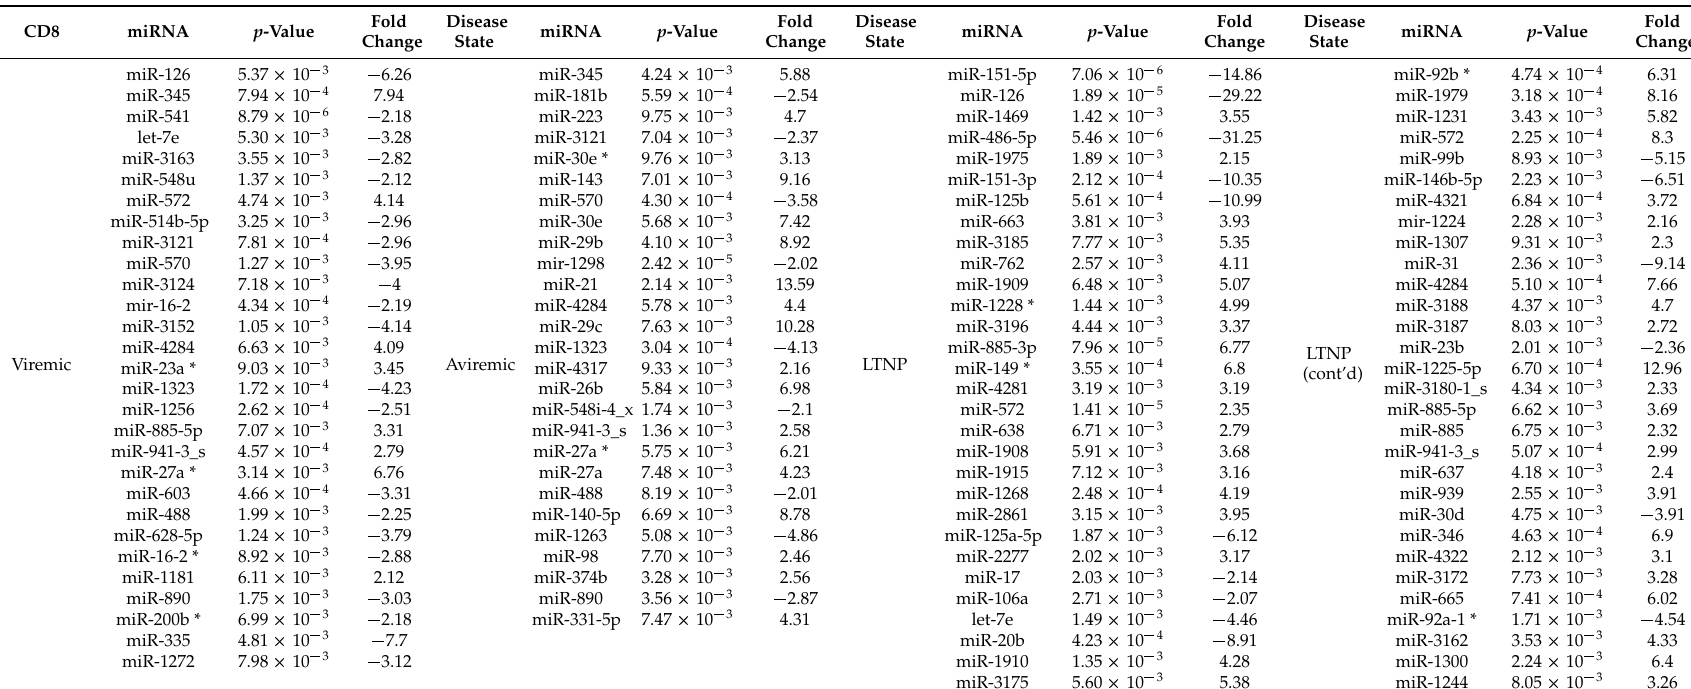
Table A4. Differentially expressed miRNAs of CD8+ T-cells in each disease state when compared to negative controls. CD8 miRNA p -Value Fold Change Disease State miRNA p -Value Fold Change Disease State miRNA p -Value Fold Change Disease State miRNA p -Value Fold Change